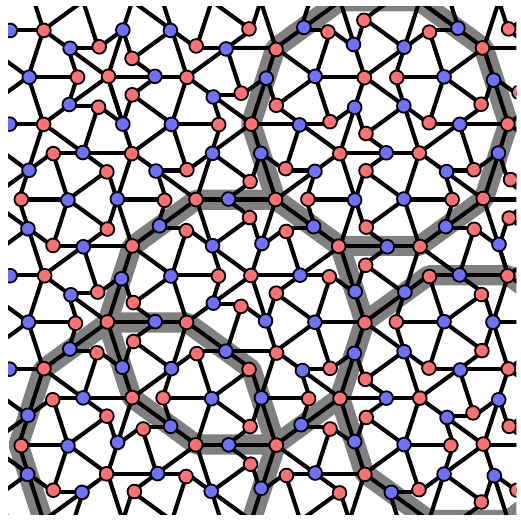
FIG. 14. A region of the Penrose dart-kite ( P 2 ) tiling. The vertices (Fig. 3) divide into bipartite sublattices: star-queen-king- ace (red) and deuce-jack-suns (blue). Dark gray decagons indicate cartwheels , regions which can cover the infinite tiling allowing for overlaps [81].